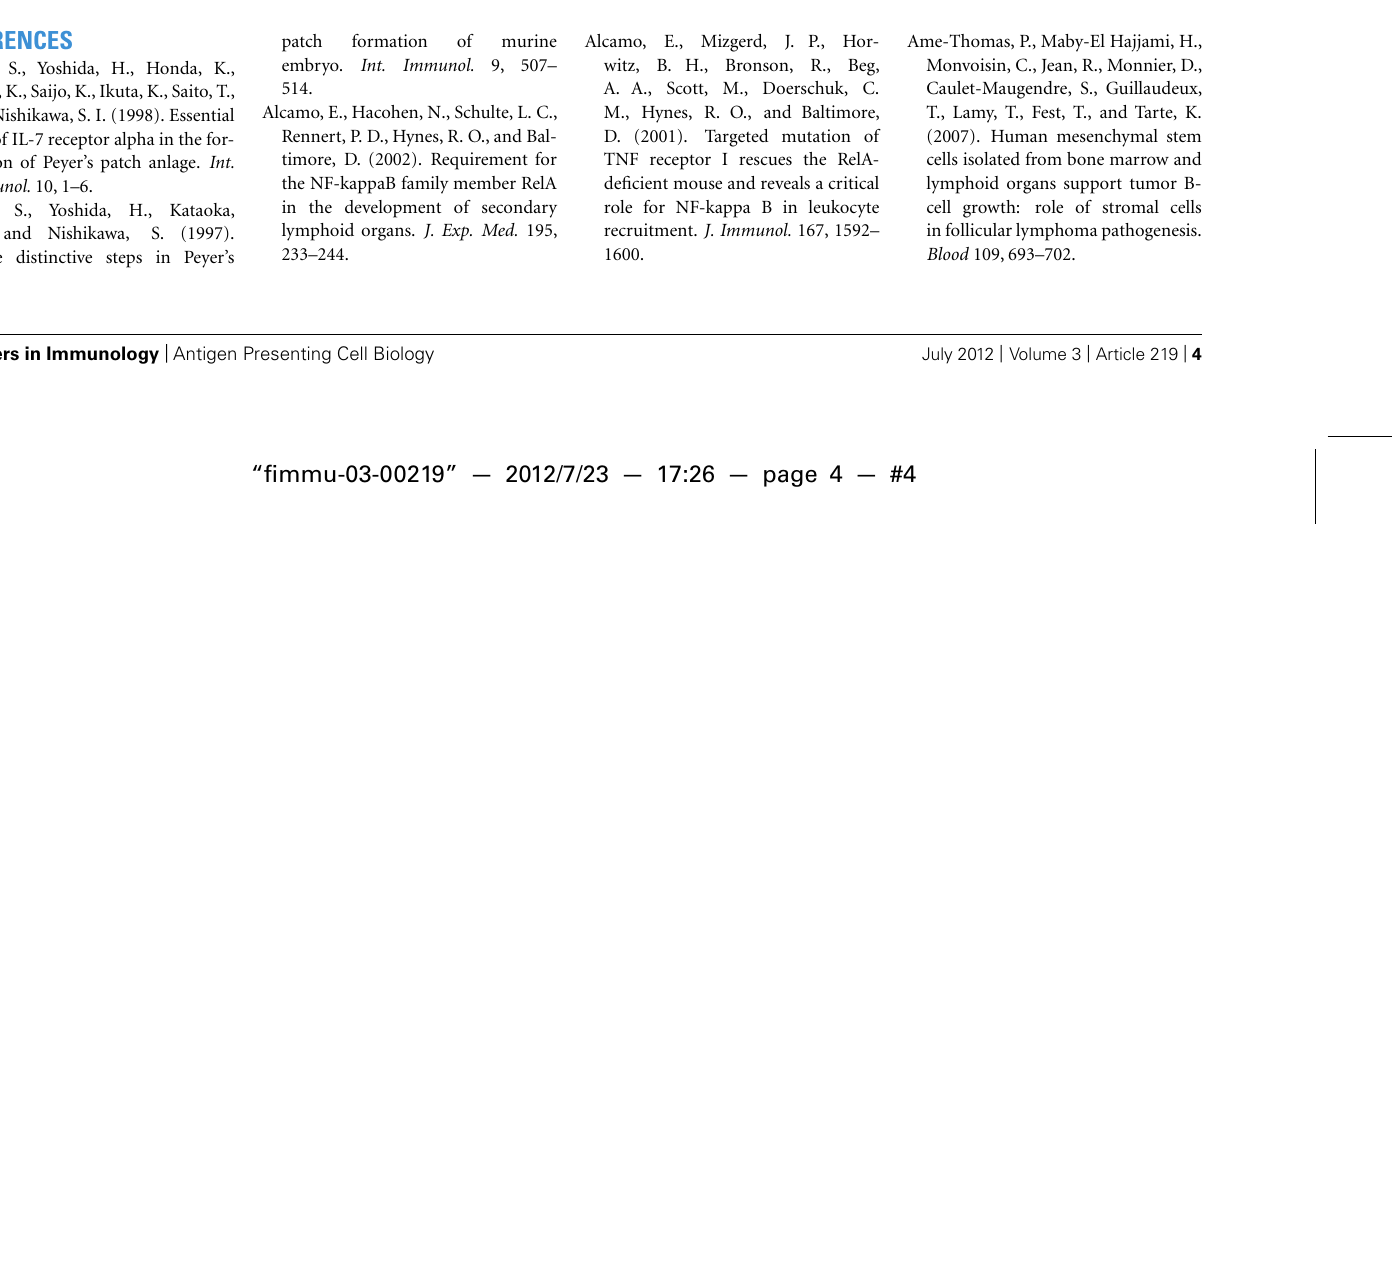
through aVCAM1 mediated process; LTi/LTo interaction through LT αβ / LT β R inducing a chemokine and adhesion molecule competent LTo cell (mature LTo cell). Step 3: Positive feed-back loop generating fully mature LTo cells and additional LTi cell recruitment and retention into the